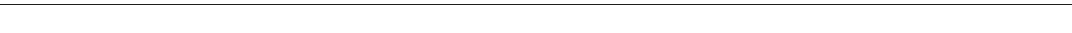
Fig. 7 Multisynaptic viral tracing approach reveals MS neurons that receive monosynaptic input from the mNTS directly project to the dHPC (dCA3 and DG). a Unilateral iontophoretic co-injection of AAV2/1-hSyn-Cre and CTB (CTB-ir in green; to con fi rm injection site placement) in the mNTS ( n = 3 double hits, n = 13 controls), which drives Cre expression in second-order (but not third-order) neurons based on synaptic virion release from fi rst-order axon terminals 18 . Scale bar: 100 μ m. b , c A 200 nl pressure injection site of a Cre-dependent anterograde tracer (AAV1-CAG-FLEX-TdTomato) in the MS Scale bar: b 200 μ m, c 50 μ m. Axon terminal fi elds in the d , e dCA3 and h , i DG of MS neurons that receive direct input from mNTS. Scale bar: d , h 250 μ m, e , i 50 μ m. A schematic representation of dCA3 ( f , g ) and DG ( j , k ) axon terminal fi eld distribution (Made by co-author and adapted from Swanson atlas level 28 – 30 68 ). (aco anterior commissure, AP area postrema, CA3sr CA3 stratum radiatum, CA3sp CA3 pyramidal layer, DGmo dentate gyrus molecular layer, DGpo DG polymorph layer, DGsg DG granule cell layer, mNTS medial nucleus tractus solitarius, MS, medial